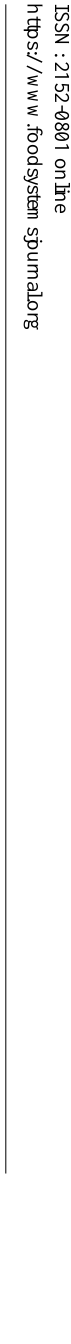
Table 1. Minigrant Program